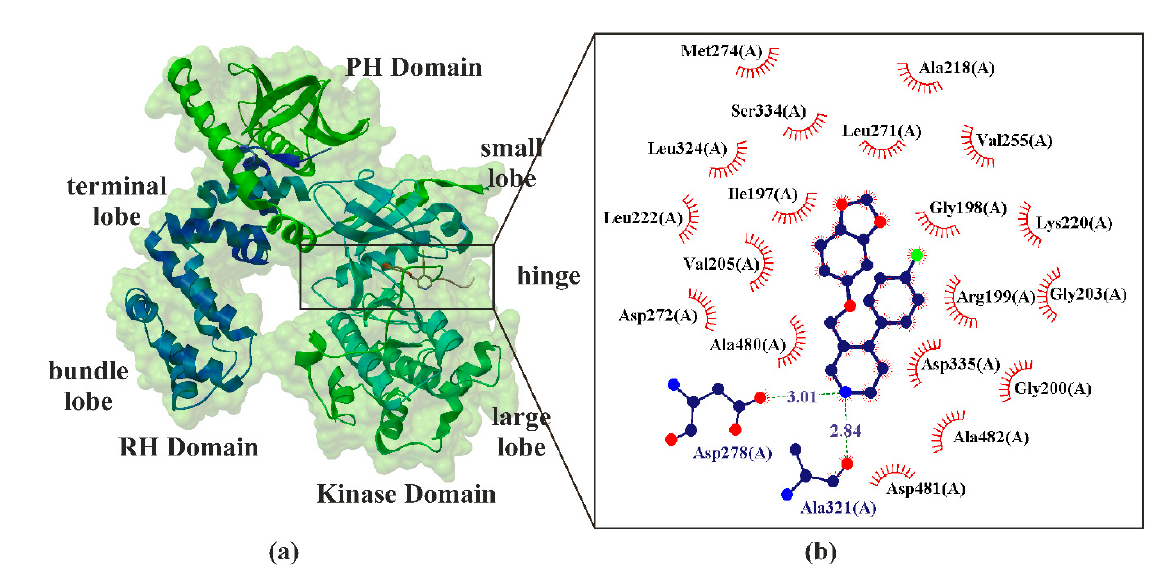
Figure 4. X-ray structure of paroxetine bind in the hinge region of G-protein-coupled receptor kinase 2 (GRK2) ( a ), with the enlarged area showing the structural elements around the ligand-biding site (PDB ID: 3V5W, 2.07 Å) [56,57]. Residues that form hydrogen bonds (dashed lines) with paroxetine are shown in ball-and-stick representation with the interatomic distances shown in Å. Residues forming Van der Waals interactions with paroxetine are shown as labeled arcs with radial spokes that point toward the ligand atoms ( b ).